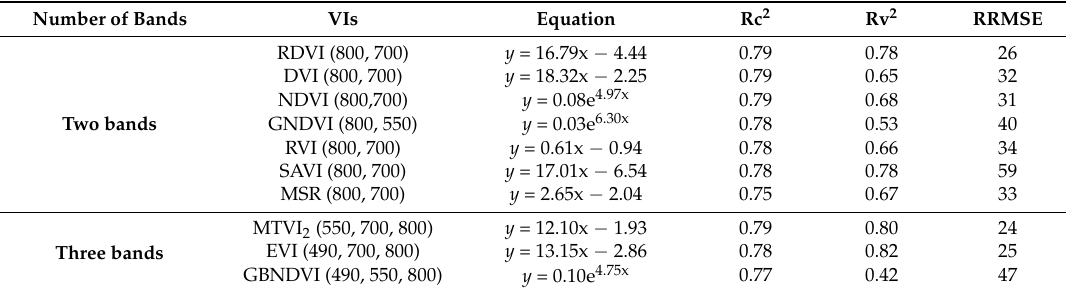
Table 5. Quantitative relationship between LAI and VIs from UAVs image.